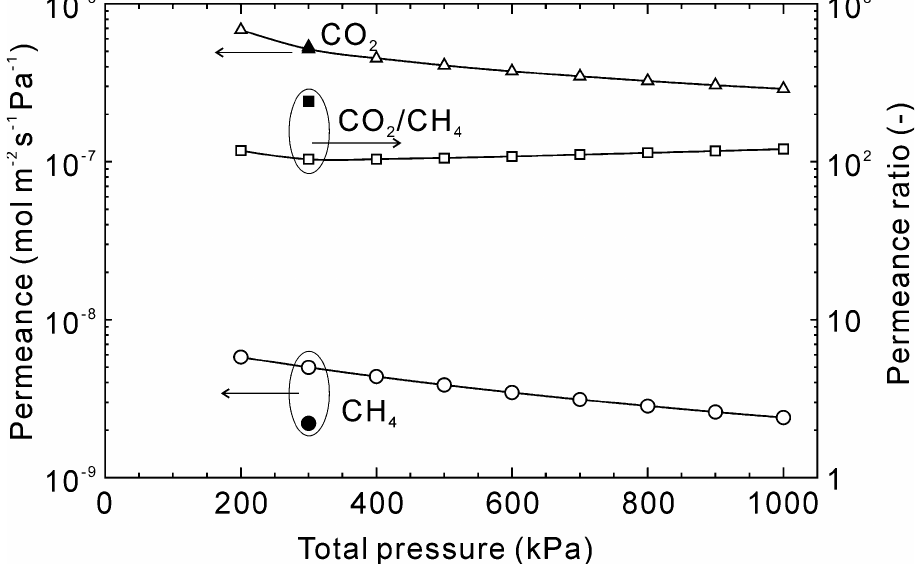
Figure 10. Influence of total pressure on the permeation properties through the CHA-type zeolite membrane with Si/Al = 18.2 at 303 K. The permeation properties were calculated at a CO 2 concentration of 50 vol%, and experimental data were taken from [28].